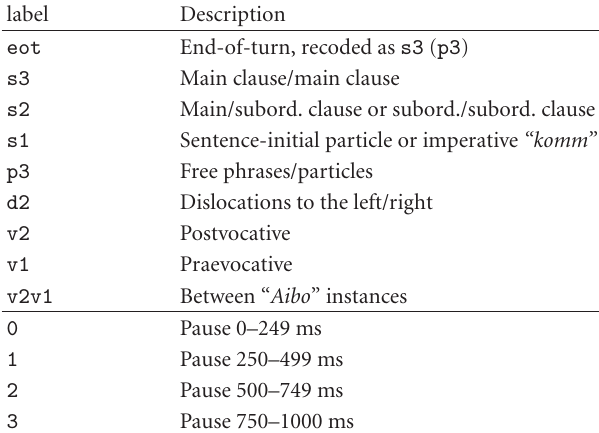
Table 2: Syntactic and pause labels; frequencies given in Table 3.